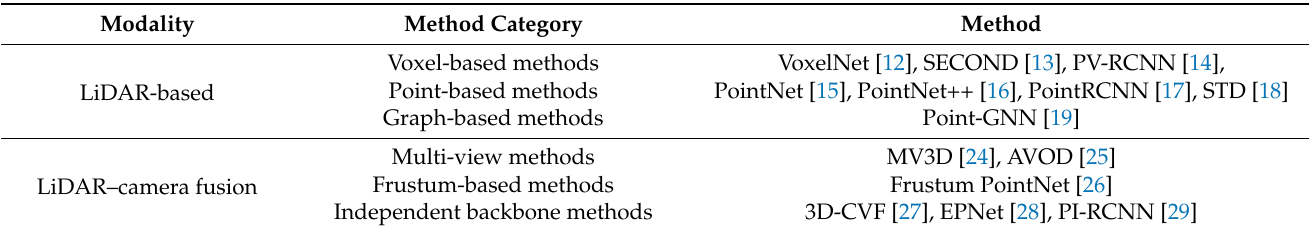
Table 1. Classification of different methods using LiDAR.